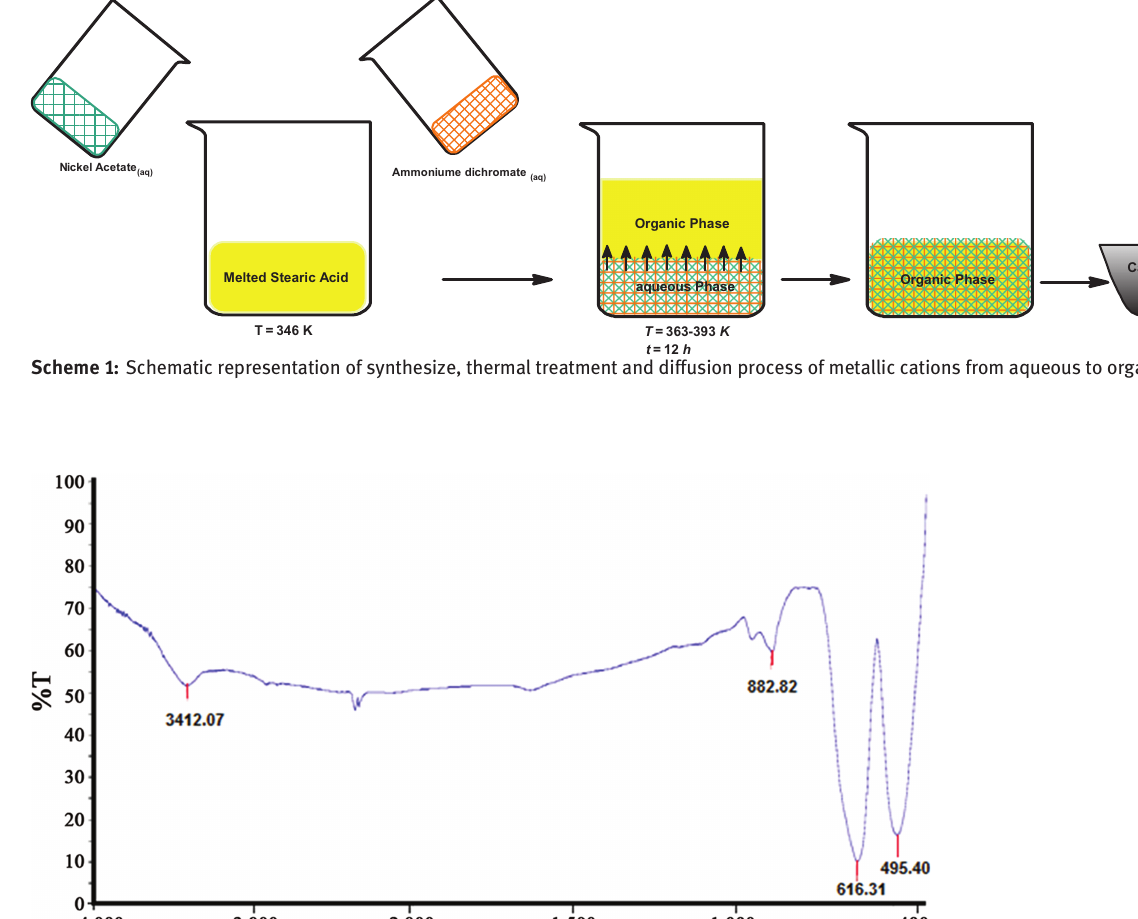
Figure 1: FTIR spectrum of NiCr 2 O 4